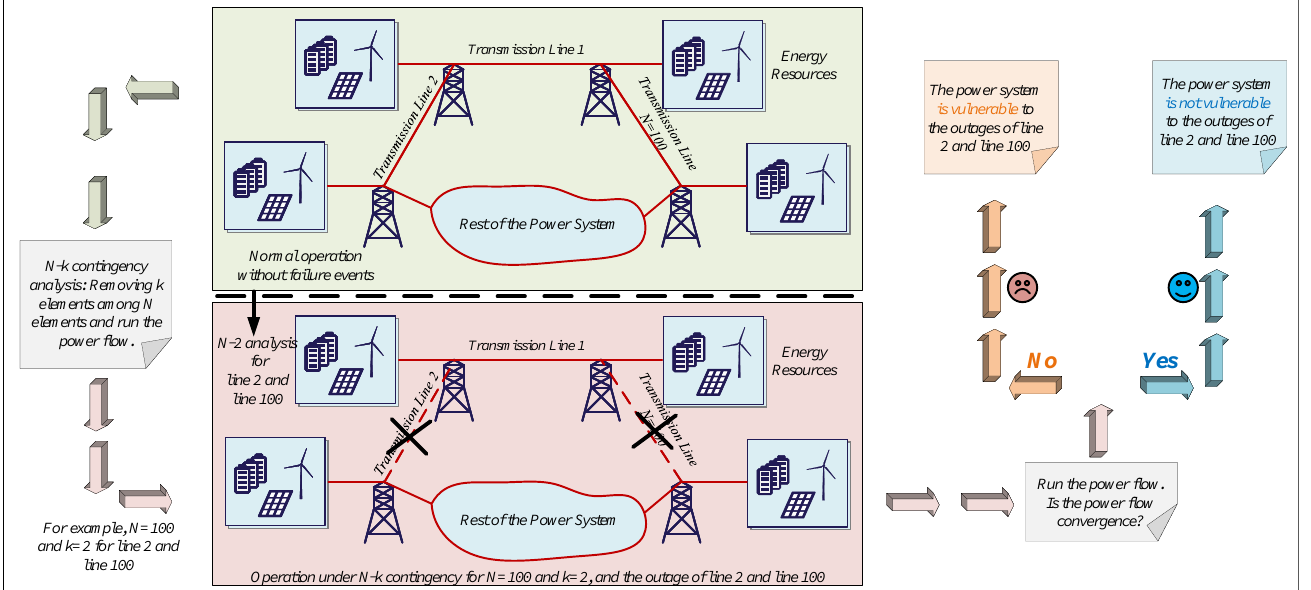
Figure 4. Contingency analysis of a power system with 100 transmission lines under N −